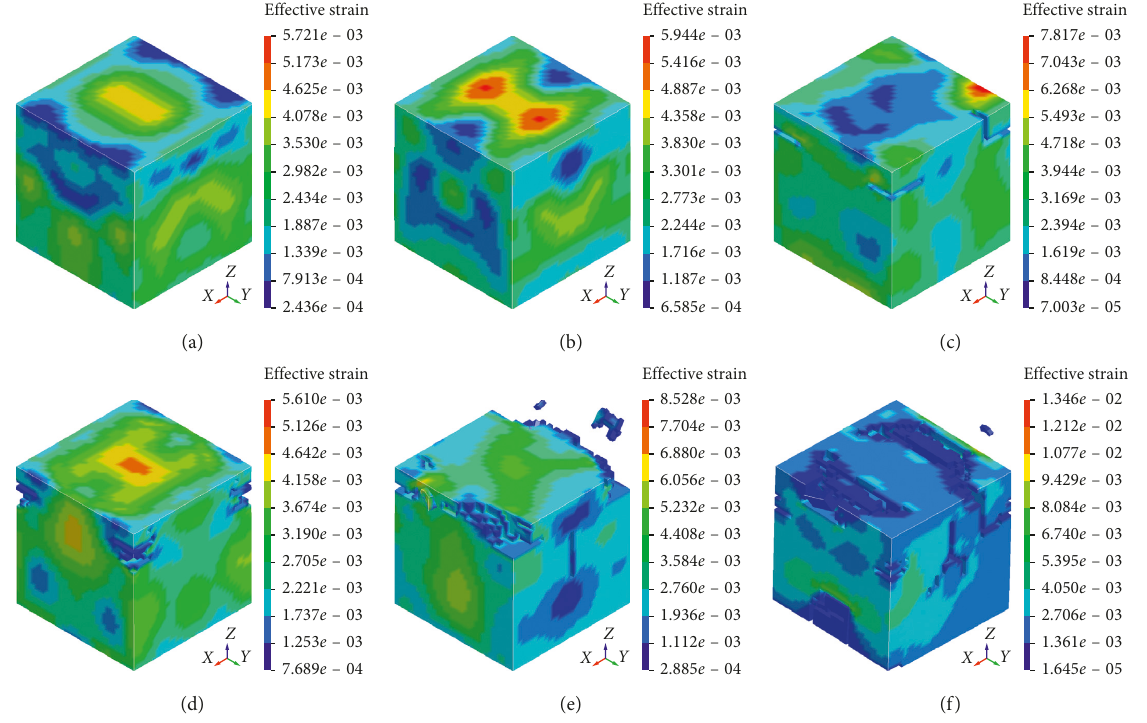
Figure 6: Relationship between effective strain and impact velocity of coal rock. (a) v (d) v 4.15m/s. (e) v (cid:31)